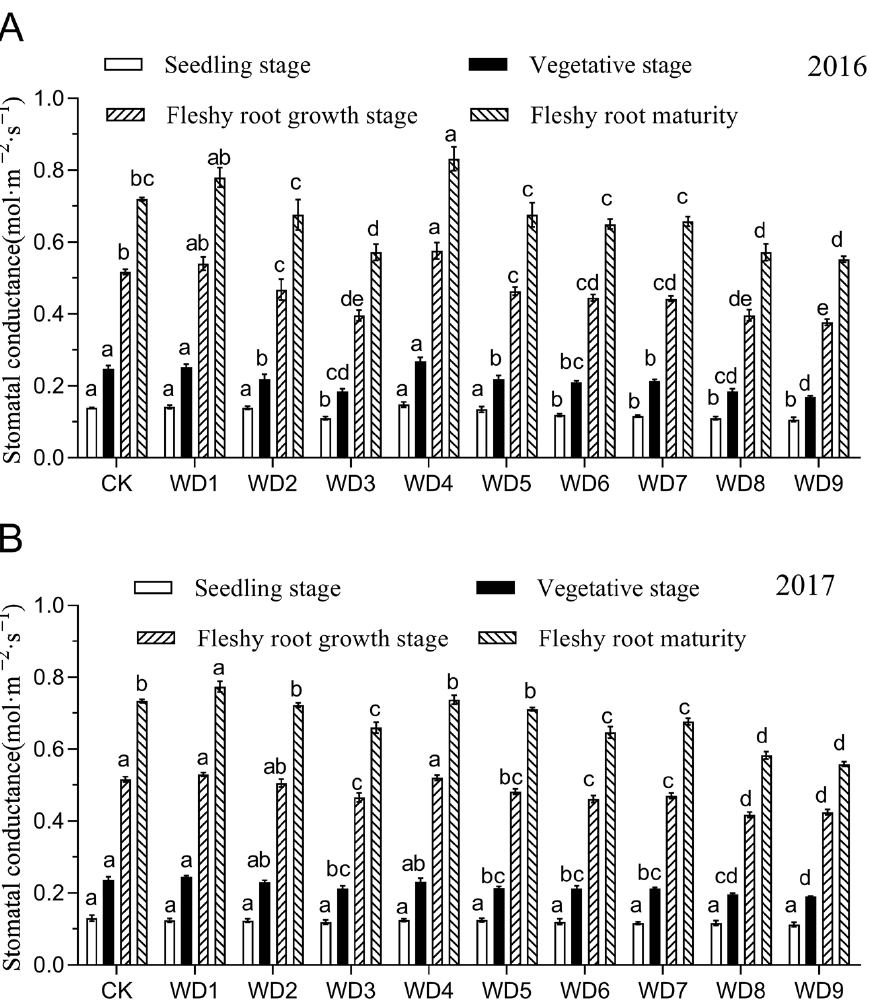
Figure 3. Stomatal conductance under various water treatments across the 2016 and 2017 cropping seasons. Different lowercase letters within a column indicate a significant difference among treatments at p < 0.05. ( A ) The experimental data in 2016. ( B ) The experimental data in 2017. WD1: mild water deficit in the vegetative stage, WD2: moderate water deficit in the vegetative stage, WD3: severe water deficit in the vegetative stage, WD4: mild water deficit in the vegetative stage and fleshy root growth stage, WD5: mild water deficit in the vegetative stage and moderate water deficit in the fleshy root growth stage, WD6: moderate water deficit in the vegetative stage and mild water deficit in the fleshy root growth stage, WD7: moderate water deficit in the vegetative and fleshy root growth stage, WD8: severe water deficit in the vegetative and mild water deficit in the fleshy root growth stage, WD9: severe water deficit in the vegetative and moderate water deficit in the fleshy root growth stage, CK: normal water supply in all growth